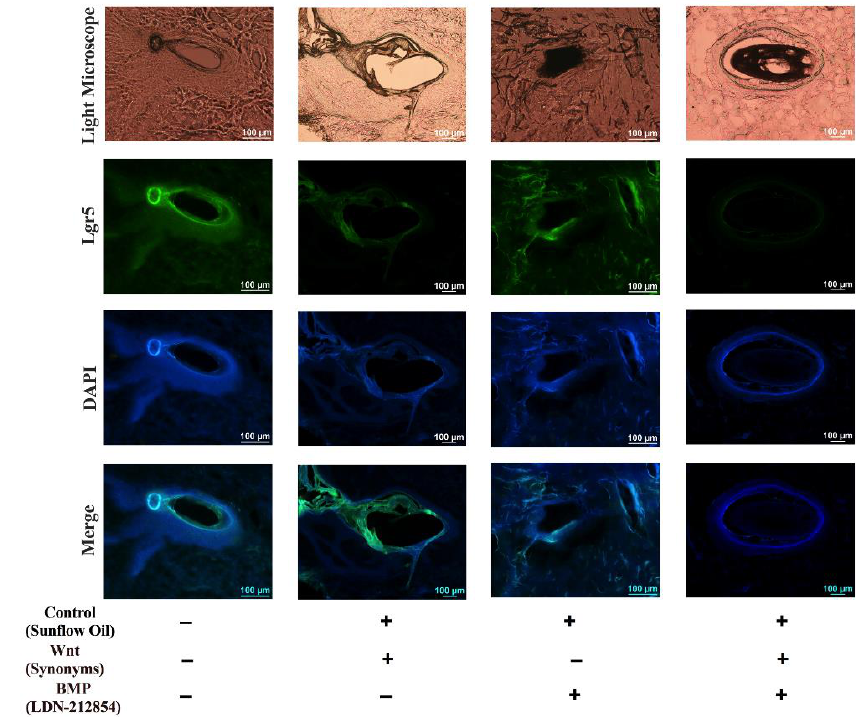
Figure 6. The indirect immunofluorescence was used to study the follicle stem cells with the marker of Lgr5 in the hair follicle of frozen section from Min pig. The Wnt and BMP singles play the role in the inhibition of the hair follicle stem cells, which cause the fail to induce follicle growth.